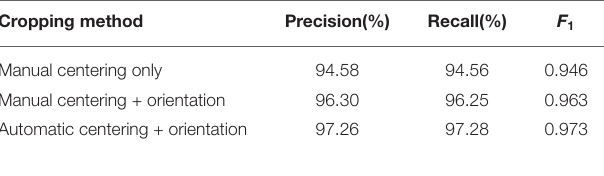
TABLE 4 | Performance of pollen detection at the image level.